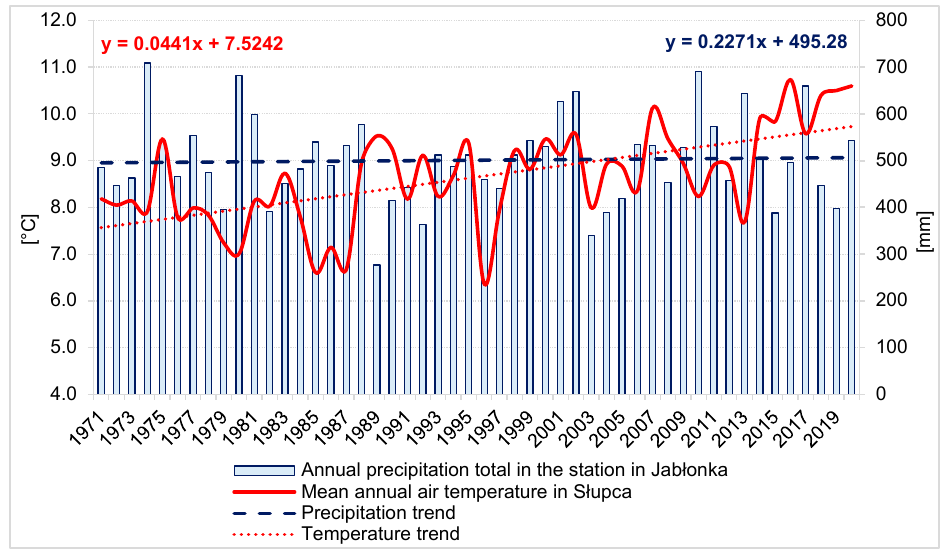
Figure 2. Climatograph illustrating changes in mean annual temperature and precipitation amount in the study area in the period 1971–2020 (based on the data of Institute of Meteorology and Water Management—National Research Institute—IMGW ‐ PIB). Table 1. Characteristic precipitation amounts in the study area for the years 1971–2020 (based on data of IMGW ‐ PIB).